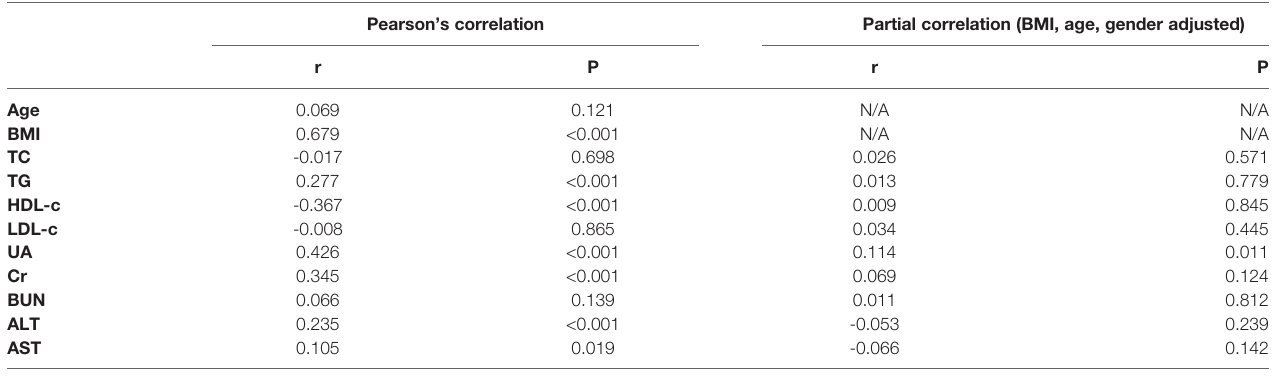
TABLE 2 | Correlation of anthropometric and metabolic variables with SMFI. Pearson ’ s correlation Partial correlation (BMI, age, gender adjusted)